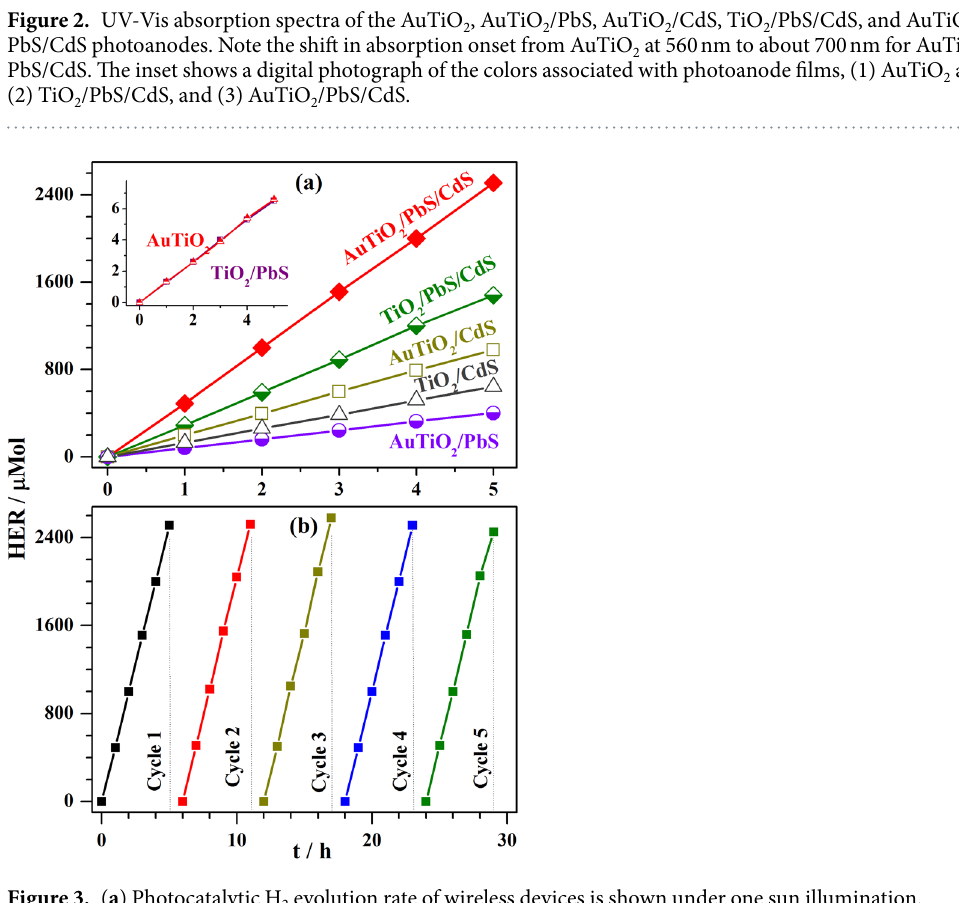
Figure 3. ( a ) Photocatalytic H 2 evolution rate of wireless devices is shown under one sun illumination. Photochemical cell was immersed in the electrolyte (Na 2 S/Na 2 SO 3 ) solution. ( b ) Photostability of the AuTiO 2 / PbS/CdS wireless device is demonstrated by performing the experiment for five